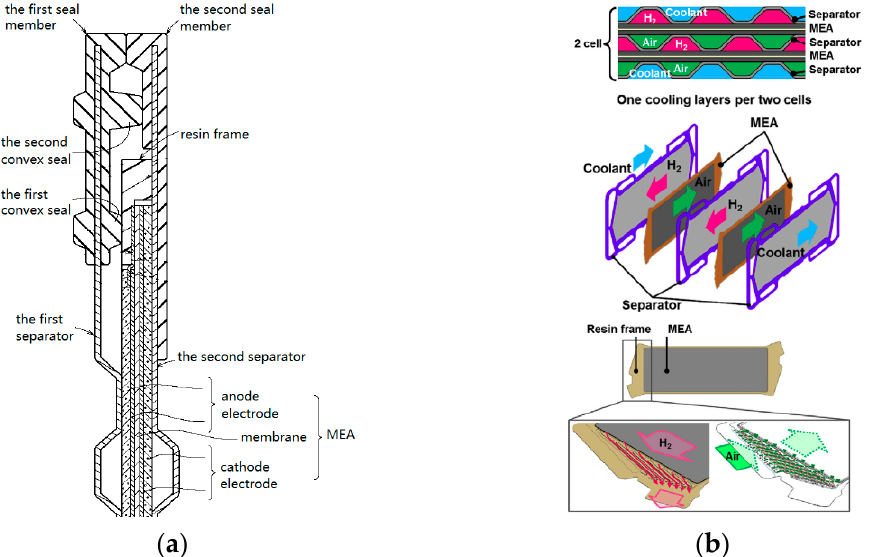
Figure 3. The seal member is integrated on the separator. ( a ) cross-sectional view of MEA [22]; ( b ) fuel cell structure and resin frame [25].